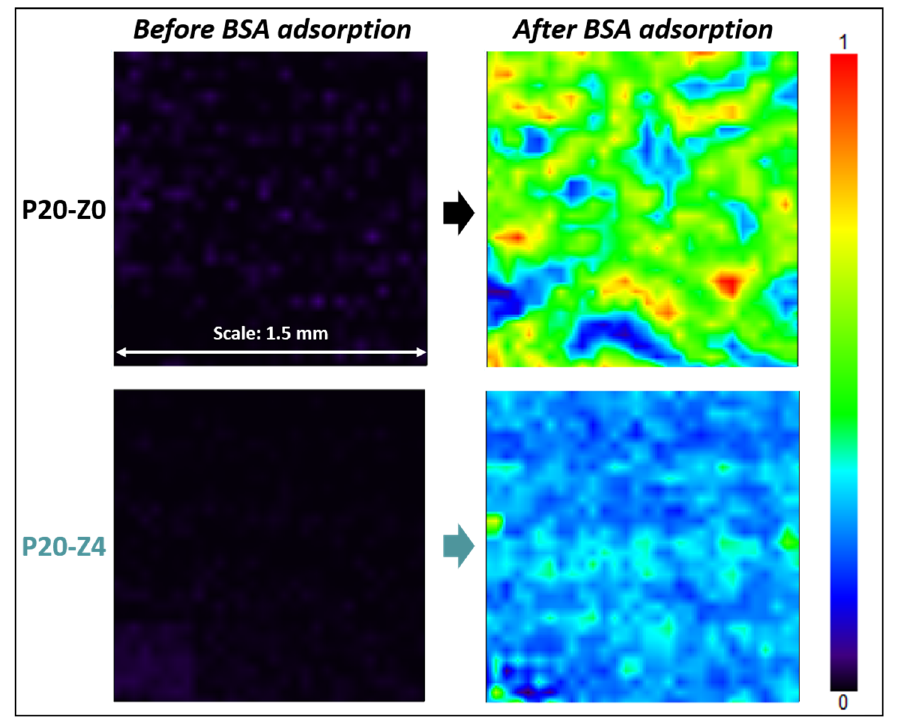
Figure 11. Effect of the additive on BSA adsorption. FT-IR maps at 1650 cm − 1 of P20-Z0 and P20-Z4 before and after incubation with BSA solution.